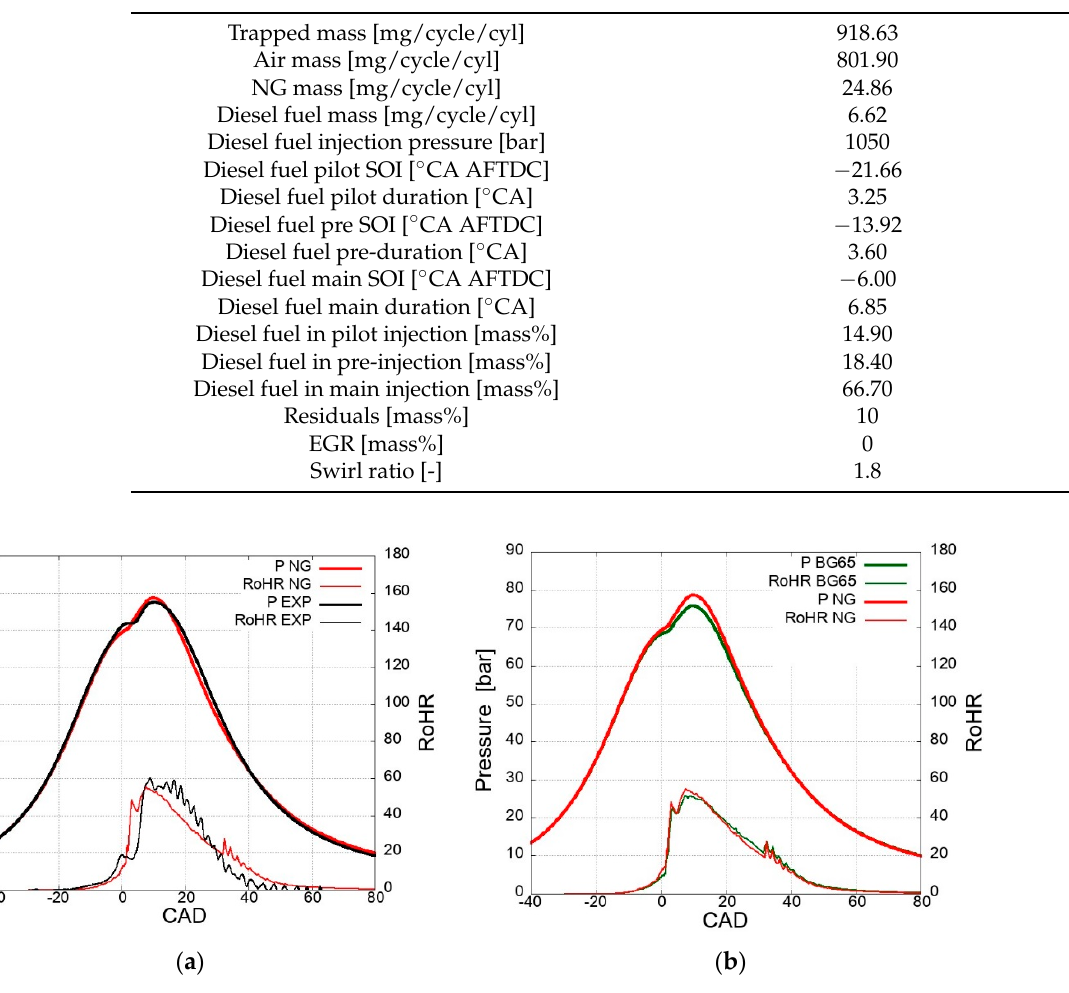
Table 4. Main engine parameters of the experimental validation case.